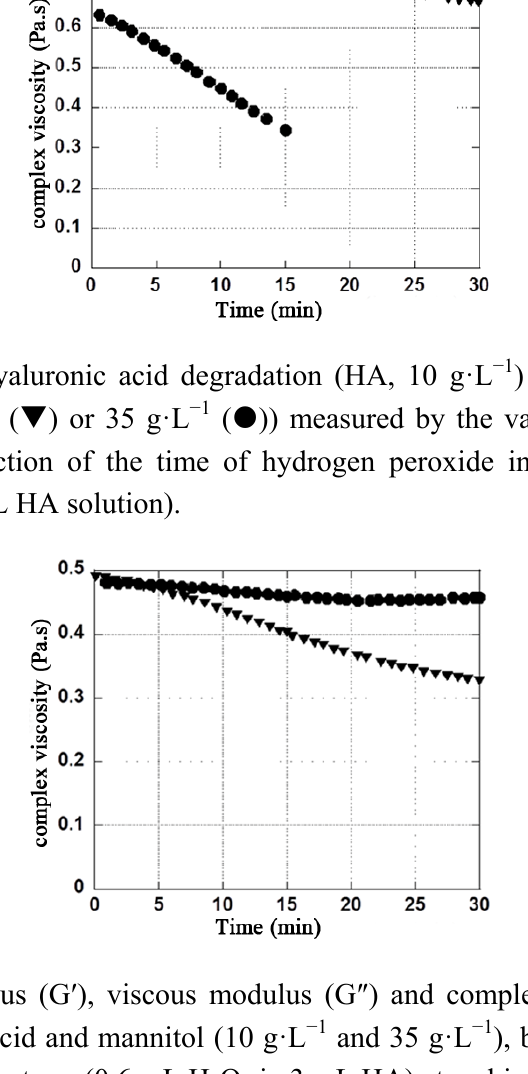
O in 3 mL HA solution) in presence (  ) and 2 2